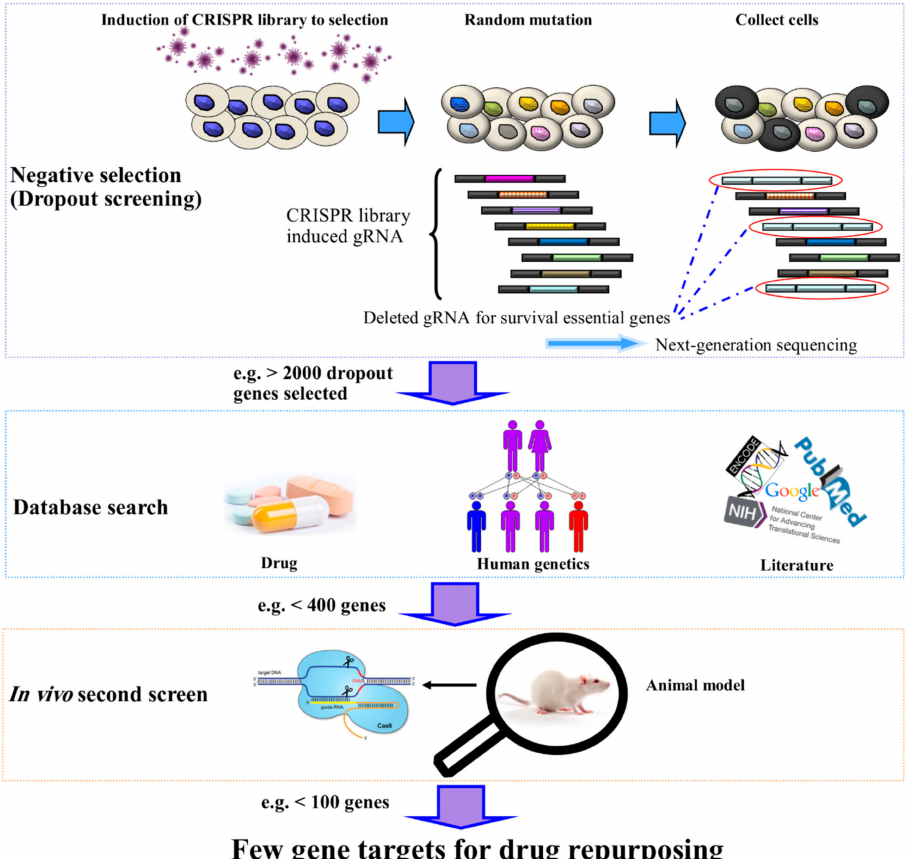
Figure 4. Pipeline of drug repositioning for a specific cancer or other disease. First, clustered regularly interspaced short palindromic repeats (CRISPR)-Cas9 dropout screening is applied for a negative selection of survival essential genes. Second, the number of dropped out selected genes is diminished by collecting information from databases and literature reviews. Third, in vivo CRISPR-Cas9 screening of an animal model of cancer or another disease will result in a few gene targets. Finally, FDA-approved drugs or those which have passed primitive phases of clinical trials could be tested as inhibitors for discovering essential survival